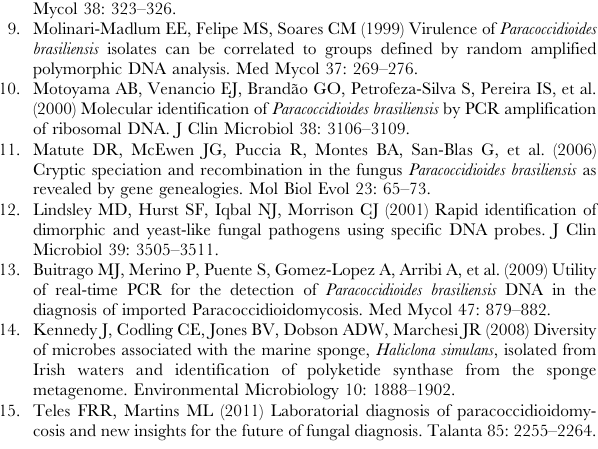
Figure S1 The primer pair OliPbMB1/OliPbMB2 gen- erate fragments of the same size both in P. brasiliensis as in P. lutzii . M, molecular marker of 100 bp; 1, negative